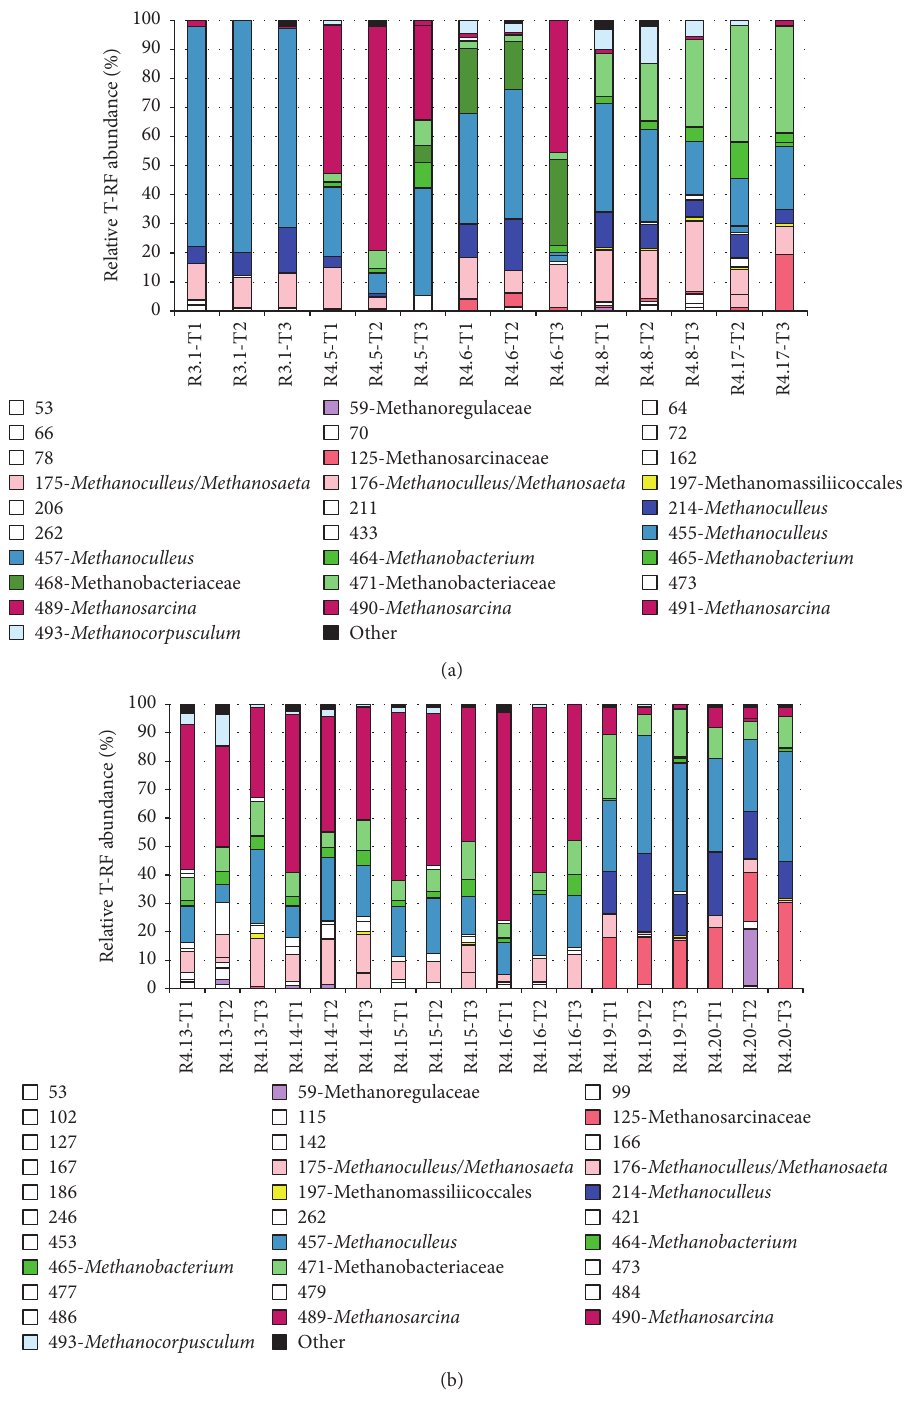
Figure 2: Community structure and dynamics of methanogenic archaea in 11 reactors at three sampling times (T1, T2, and T3; see Table S1 for details) according to T-RFLP profiles of mcrA amplicons digested with the restriction enzyme Hae III (reactors R3.1, R4.5, R4.6, R4.8, and R4.17 (a); reactors R4.13, R4.14, R4.15, R4.16, R4.19, and R4.20 (b)). Only T-RFs comprising at least 1% relative abundance in at least